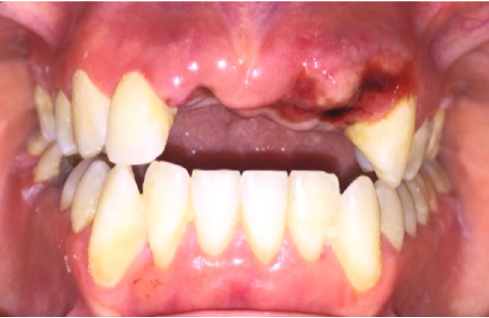
Figure 1: Intraoral view showing avulsion of teeth 11, 21, and 22.